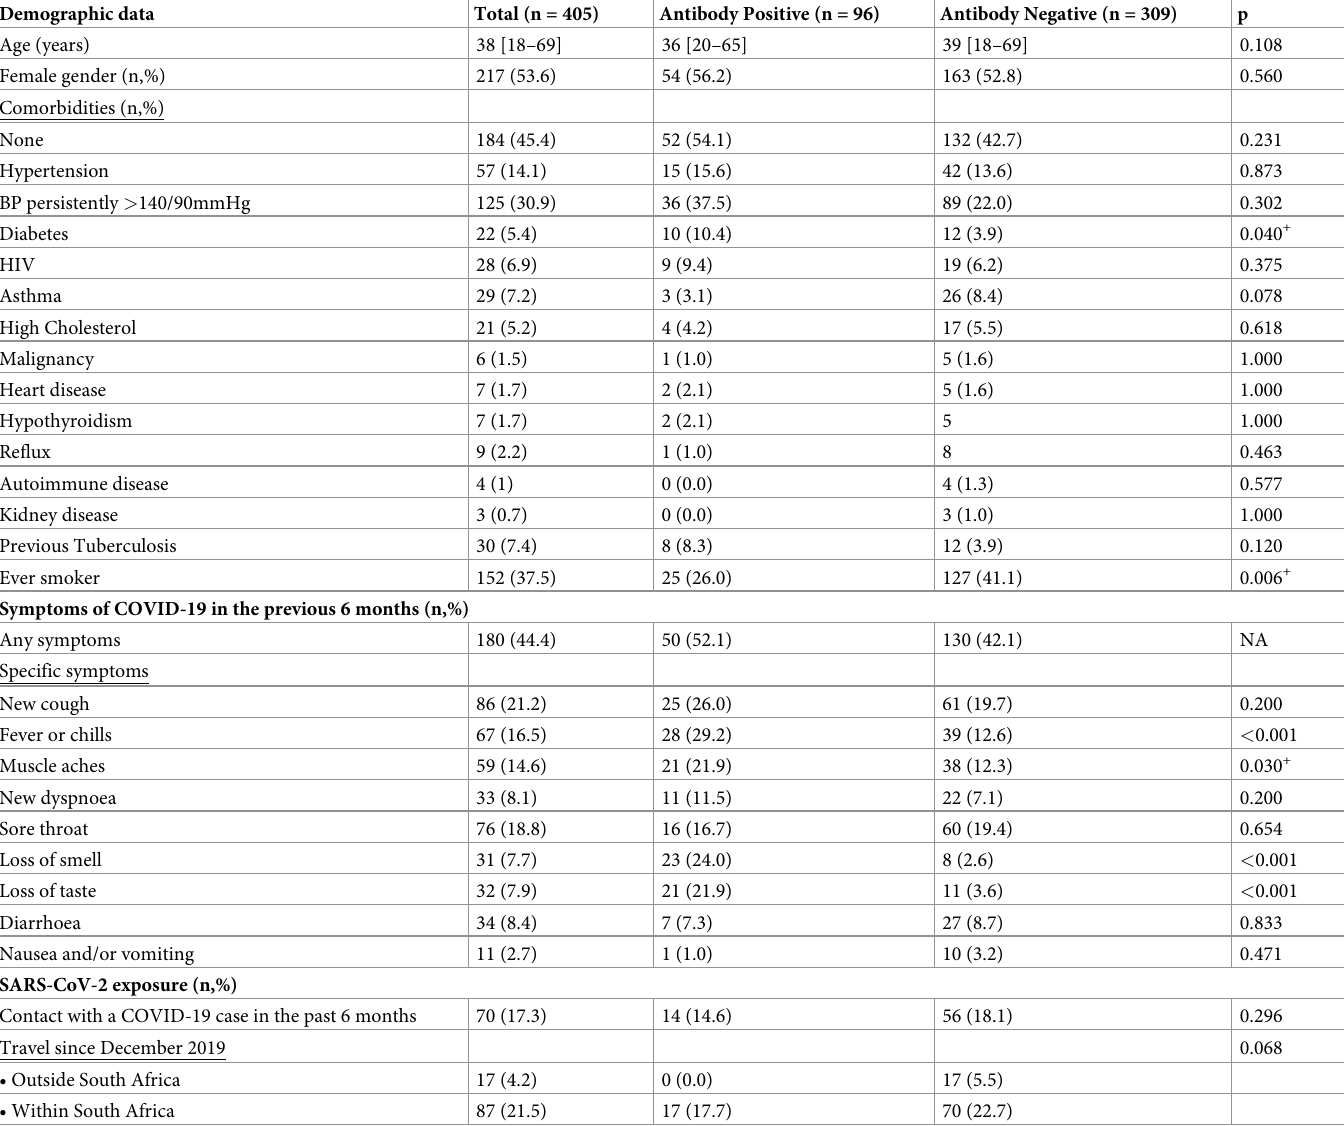
Table 1. SARS-CoV-2 seroprevalence, comorbidities, COVID-19 symptoms and